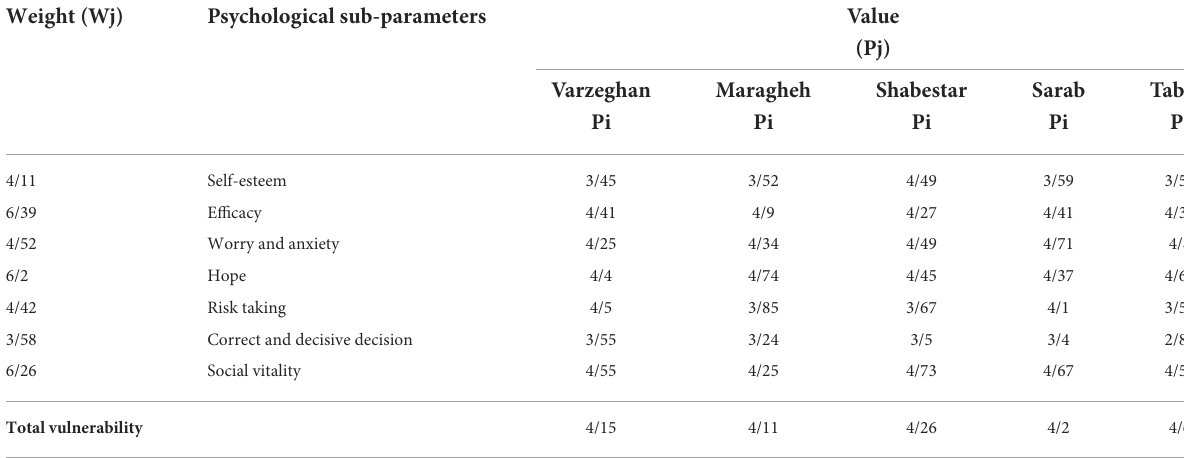
TABLE 4 The values and weights of farmers’ psychological vulnerability parameters. Weight